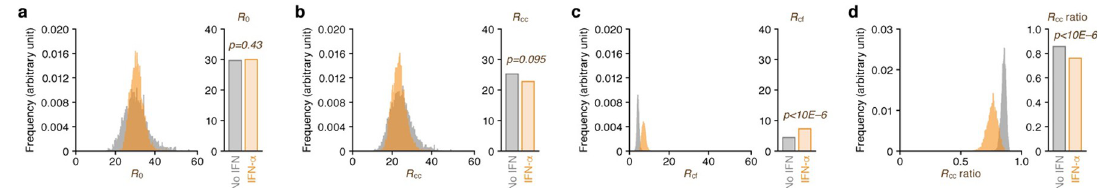
Fig 4. Distributions of basic reproduction numbers of HIV-1 NL4-3 infection. a-d The comparison of basic reproduction numbers in the absence or presence of IFN- α . (Left) The distributions of R 0 ( a ), R the MCMC methods, are shown. The contribution of the cell-to-cell infection (i.e. R we sampled 20,000 parameter sets from MCMC computation among 150,000 samples. For detail, see Methods. (Right) The bars indicate the mean values computed by the MCMC method. Orange and gray respectively indicate the data with and without IFN- α treatment. The p values are calculated by Brunner Munzel test.